Question: Provide a one-line summary of what is displayed.
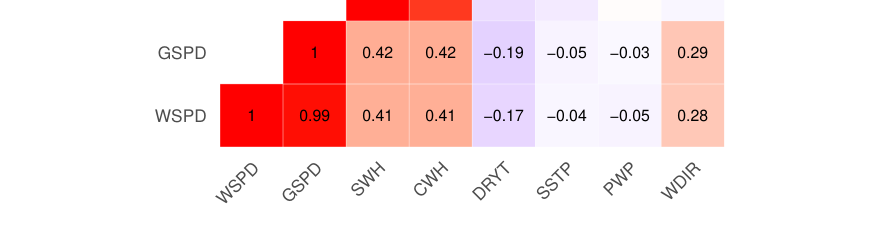
Answer: Heatmap showing the pairwise correlation across all variables in the data set.